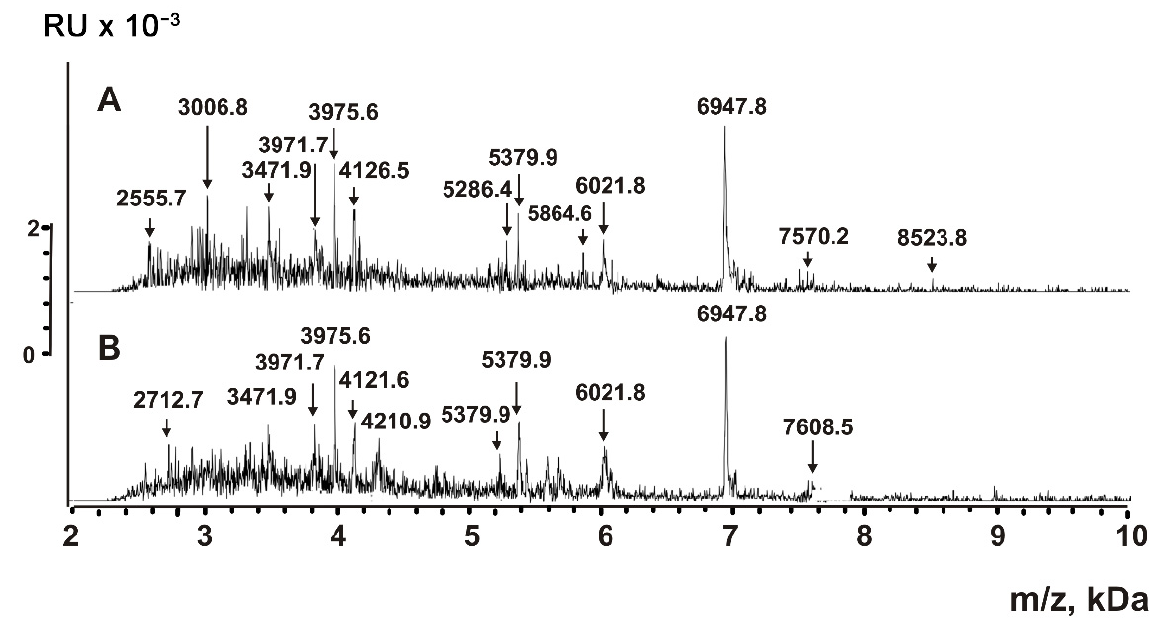
Figure 6. Direct MALDI mass spectrometry analysis of untreated exosomes (P2 + P3) after affinity chromatography on anti-CD9- ( A ) and anti-CD63-Sepharose ( B ). The errors in determining the m / z value did not exceed 0.5–1.0 Da. Aliquots of P2 + P3 fractions of VESmix were processed with TFA to destroy any non-covalent interactions. The insoluble compounds were removed by centrifugation; supernatants were filtered through Amicon centrifuge filters with a 10 kDa cut-off. MALDI mass spectra obtained in the 2–12 kDa range are shown in Figure 7. The spectra contain multiple peaks corresponding to compounds with molecular masses from 2.0 to 7.6 kDa.